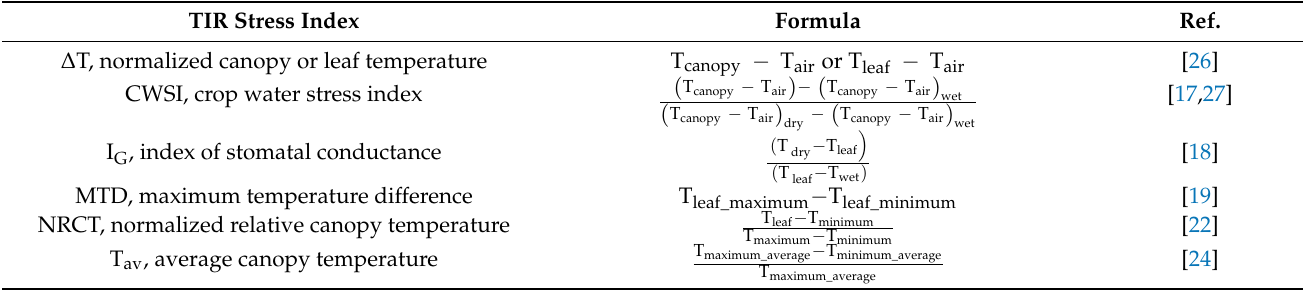
Table 1. Most commonly used thermal long-wave infrared (TIR)